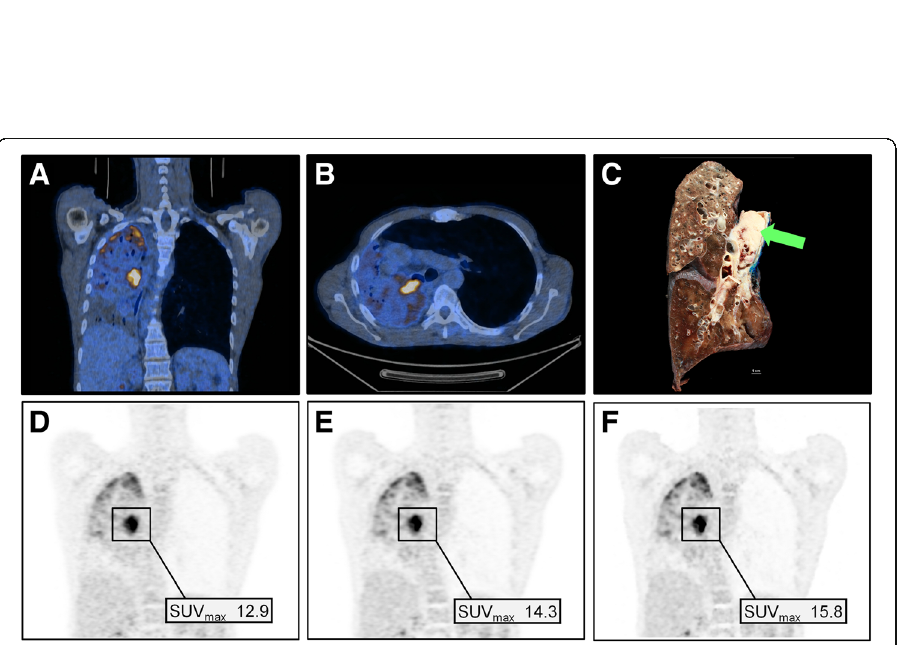
Fig. 3 Representative images of a 53-year-old man with a body mass index of 19.1 kg/m 2 and 66 kg body weight who underwent 18F-FDG PET/CT for staging of lung cancer. The patient was injected with 99.8 MBq of 18F-FDG (i.e., 1.5 MBq/kg body weight). Coronal and axial co-registered PET/CT images ( a , b ) show a highly 18F-FDG-avid tumor invading the right main bronchus, which was confirmed as squamous cell carcinoma (arrow) after right-sided pneumonectomy ( c ). Coronal PET images show OSEM TOF ( d ), OSEM PSF ( e ), and BSREM 600 ( f ) reconstruction together with SUV max of the primary tumor